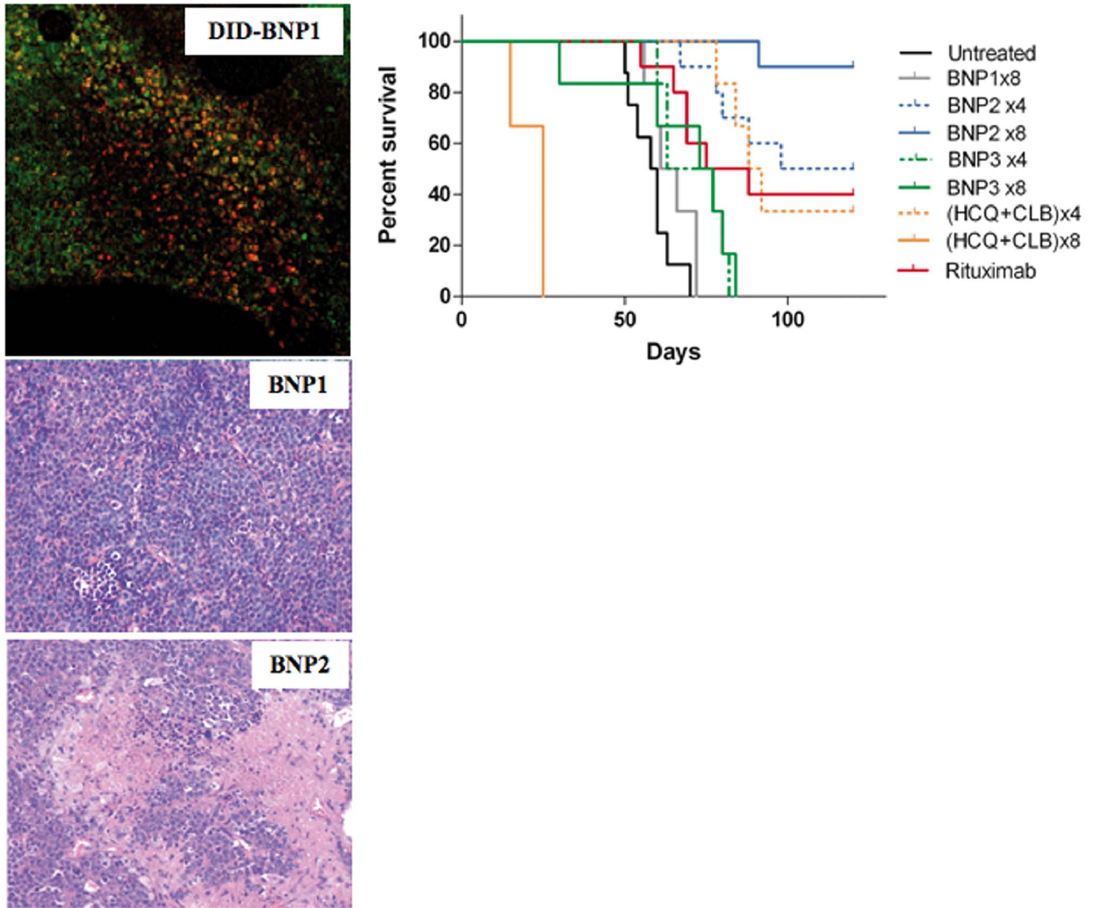
Figure 5. Therapeutic effect of BNPs, HCQ + CLB and Rituximab. A) SCID mice (n=5 per group) received 2 6 10 6 BJAB cells i.p.; Cy5.5 labeled- BNP1 or BNP2 (40 m L for 3 times in 5 days) were injected in tumor-bearing mice with a visible peritoneal tumor mass at day 25; the animals were sacrificed 7 days after the end of the treatment and the tumor masses were visualized by confocal microscopy and analyzed by H&E. Original magnification 200 6 . B) Survival curve. SCID mice (n=7–10 per group) received 2 6 10 6 BJAB cells i.p. and BNP1, BNP2, BNP3, HCQ + CLB or Rituximab as described in the results. P values. Untreated vs. BNP1: Not significant; Untreated vs. BNP2 6 4: p , 0.0001; Untreated vs. BNP2 6 8: p , 0.0001; Untreated vs. (HCQ + CLB) 6 4: p , 0.0003; Untreated vs. Rituximab: p , 0.0005; BNP2 6 4 vs. (HCQ + CLB) 6 4: Not significant; BNP2 6 4 vs. Rituximab: Not significant; BNP2 6 8 vs. (HCQ + CLB) 6 8: p , 0.0001; BNP2 6 8 vs. Rituximab: p , 0.0003; BNP3 6 8 vs BNP1: Not significant; BNP3 6 8 vs BNP2 6 4: p , 0.0005; BNP3 6 8 vs BNP2 6 8: p ,